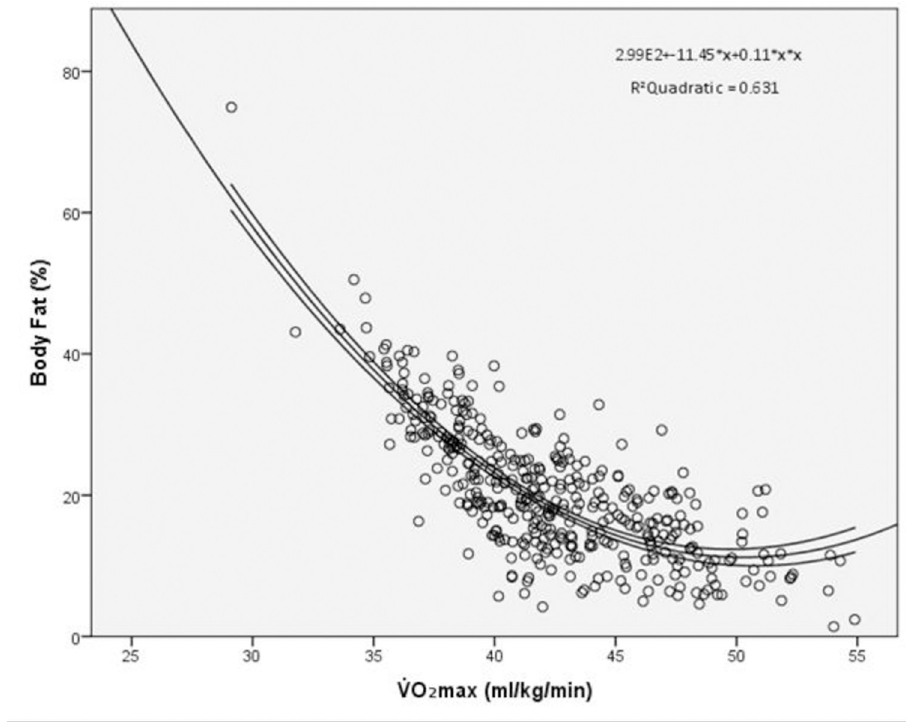
Fig 2. VO 2 max and body fat percentage linear quadratic and cubic analysis. Figure displays the nonlinear relationship between body fat (%) and VO 2 max.